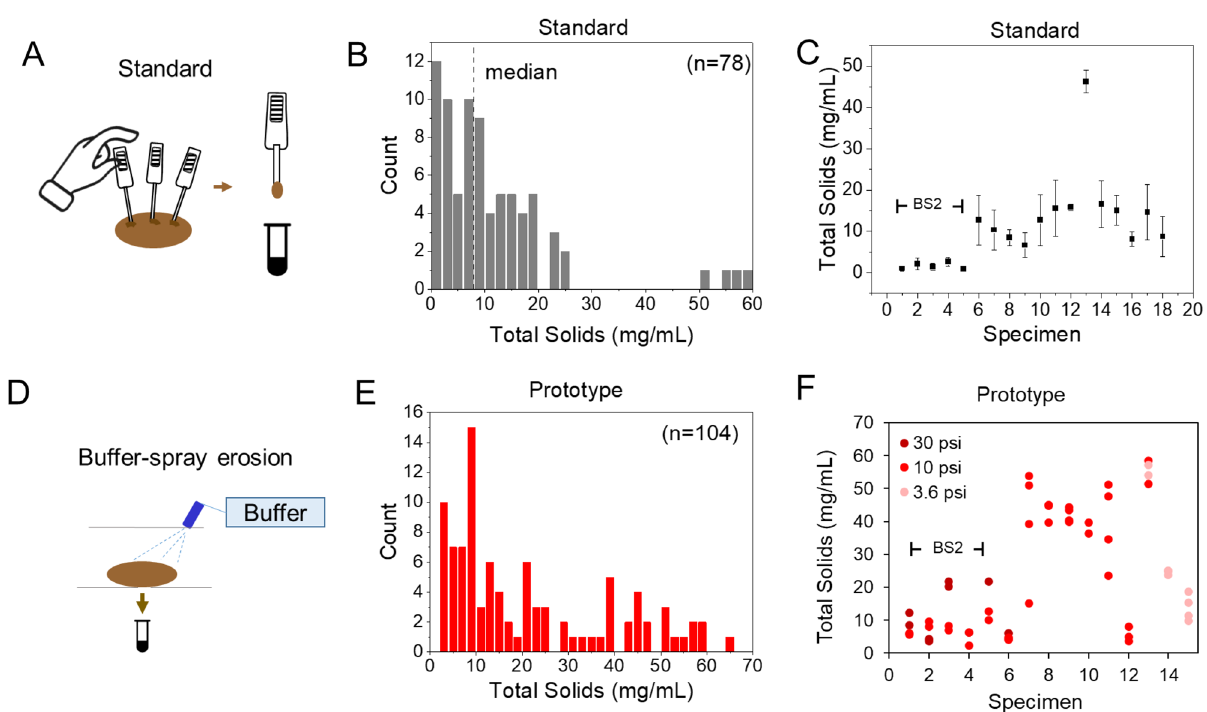
Figure 3. Specimen sampling study. Standard sampling: ( A ) Procedure illustration from the manufacturer. ( B ) Distribution of total wet solids with median value of 8 mg/mL. ( C ) Average and standard deviation of total solids from individual specimens, n = 3 to 5 for each specimen. BS2 = Bristol Stool Form Scale 2 indicates lumpy, hard consistency stool. Prototype sampling (D): Schematic. ( E ) Distribution of total wet solids collected from the prototype. ( F ) Total solids extracted from individual specimens using 5 s spraying time at the indicated